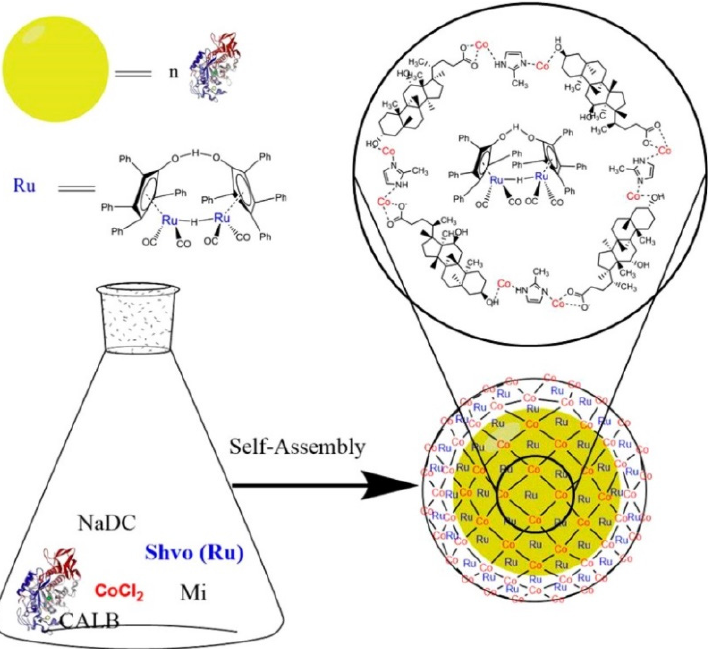
Figure 12. Immobilization of CAL-B and Shvö catalyst in a metal-biosurfactant nanocomposite [184]. NaDC = sodium deoxycholate, Mi = methyl-imidazol. Reprinted with permission from [184]. Copyright (2019) American Chemical Society.